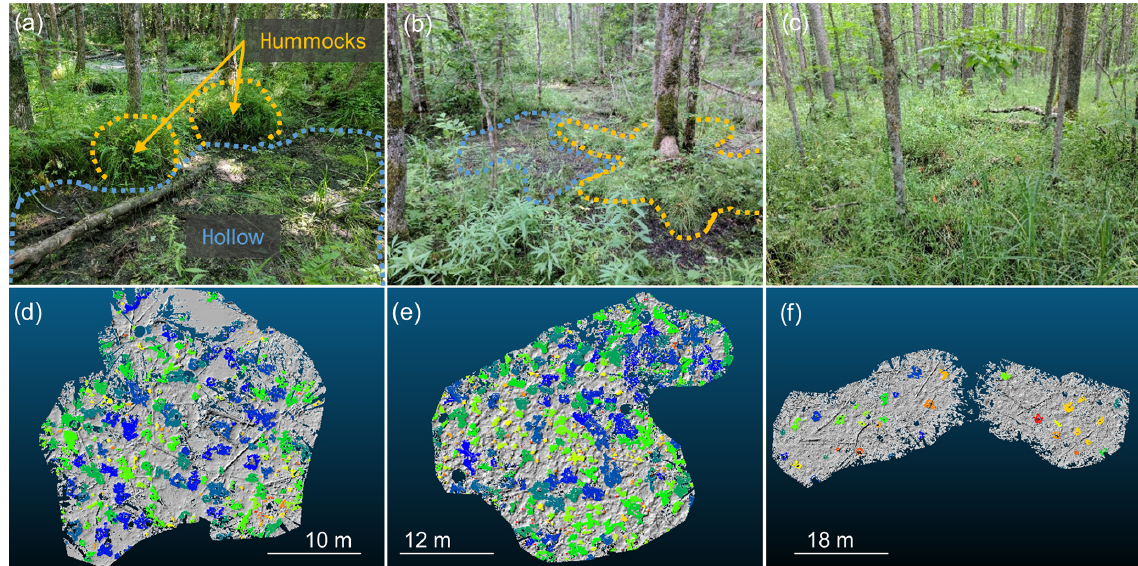
Figure 3. (a–c) Photos of observed black ash wetland microtopography from a site in each hydrogeomorphic category: (a) depression site D2, (b) transition site T1, and (c) lowland site L3. Hummocks are outlined using yellow/orange dashed lines, and hollows are outlined and lightly shaded in blue. Lowland (L3) site hummocks and hollows are difficult to discern in summer time due to heavy understory cover and are additionally less pronounced, so they are not drawn here. In contrast, depression (D2) and transition (T1) site hummocks were typically more visually distinct from hollow surfaces. (d–f) Corresponding automatically delineated hummocks for every site with hill-shaded surface models in the background: (d) D2, (e) T1, and (f) L3. Hummocks are colored at each site using a unique identifier. Although some hummocks have similar colors to their neighbors, indicating that they are the same hummock, if they are separated by gray space (hollows), they are